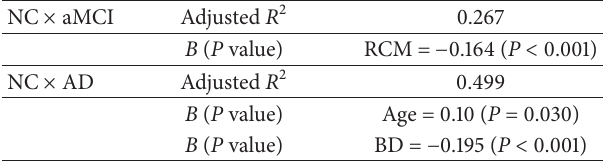
Table 4: Multivariate logistic regression analyses with clinical diag- nosisasthedependentvariablesandage,education,sex,Vocabulary, BD, and RCM as independent